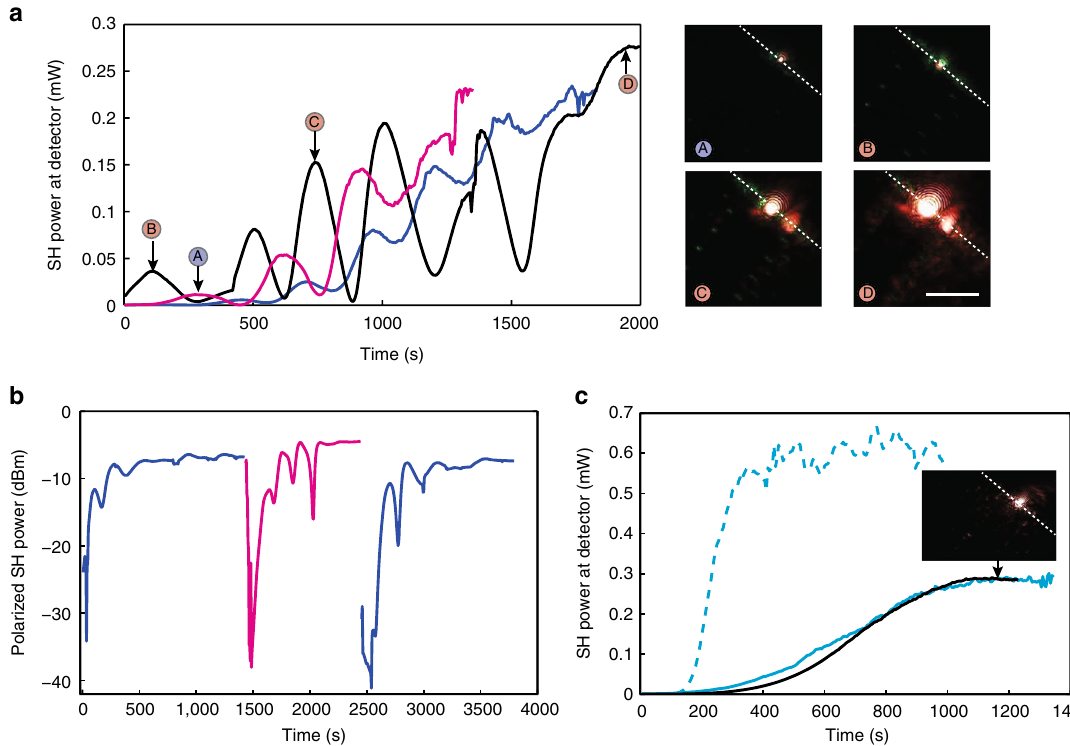
Fig. 2 Second harmonic enhancement over time under pulsed pumping. a Growth curves of the second harmonic generation (SHG) average power over time in waveguide (i), for pump wavelengths of 1539 nm (magenta line), 1544 nm (blue line) and 1549 nm (black line). The coupled peak power is 90 W. The pictures show the light scattered at the end facet, coming either from second harmonic generation (SHG, red light) or third harmonic generation (THG, green light) The edge of the chip is indicated by the dashed white line ( scale bar : 20 μ m). The labels (A)-(D) indicate the instant and for which pumping wavelength the picture was taken. b Power of the transverse electric (TE) or transverse magnetic (TM) SHG component over time when the pump polarization is switched, at the constant wavelength of 1544 nm, from the TE to TM mode, and back to TE in waveguide (i). At each switching point the polarizer is fi rst rotated by 90°, entailing a measured SHG power drop, then the pump polarization is aligned parallel to the polarizer axis, triggering the growth of the second harmonic component. Blue line: power of TE SH under TE pump. Magenta line: power of TM SH under TM pump. c SHG growth over time, for pump wavelengths of 1537 (cyan line) and 1550 (black line) nm in waveguide (ii). The coupled peak power is varied between 60 (solid line) and 90 W (dash line). The inset shows the light scattered at the end facet once saturation is reached, with very little green